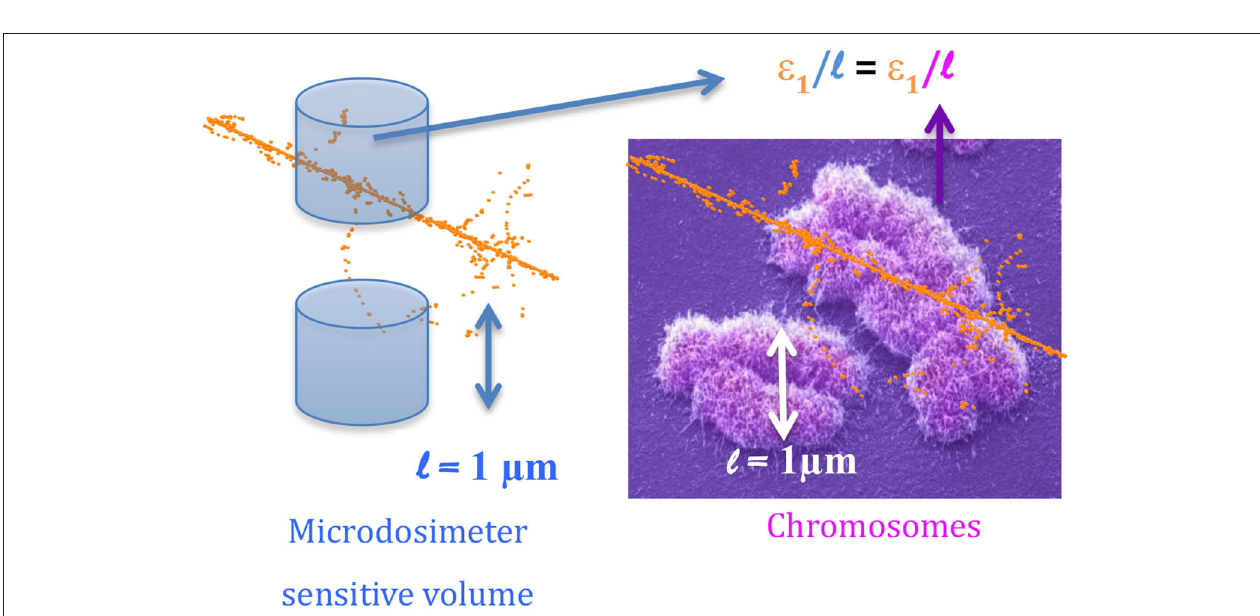
FIGURE 7 | Sketch of the microdosimetric model. The blue cylinder represents the sensitive volume V of the microdosimeter featuring a diameter of about 1 µ m, the same size of the chromosome (right side of the figure). The orange dots are points where the charged particle imparts the energy (ionization or excitation events). The energy imparted to two chromosomes by the same single particle track is different (right side of the figure). Similarly, the energy imparted to the detector by the same particle can be different.